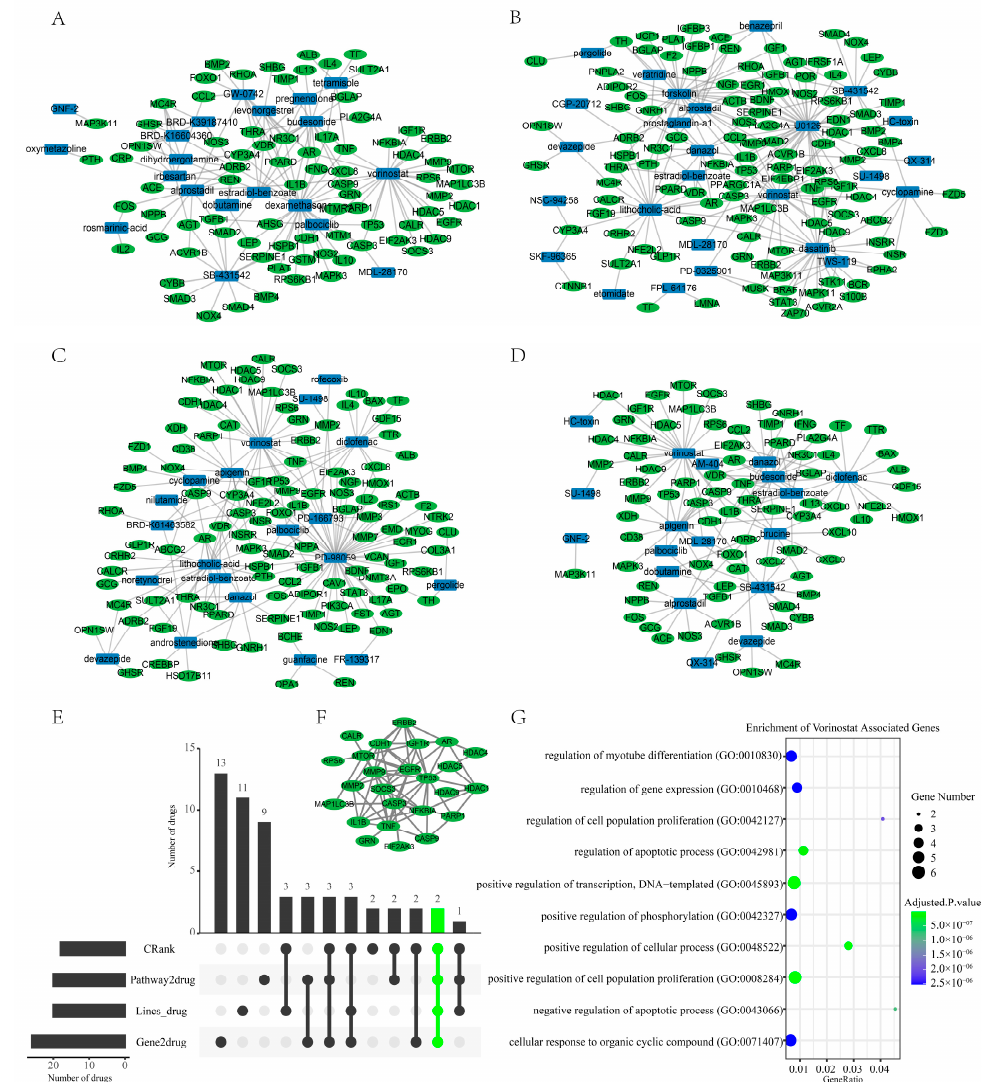
Figure 7. ( A – D ): In the top 50 drugs of the four different approaches, we showed the intersection of each with genes associated with sarcopenia (( A ): Lincs algorithm; ( B ): Gene2drug algorithm; ( C ): Pathway2drug algorithm; ( D ): Crank algorithm). There is no display of drugs that do not interact with sarcopenia-associated genes. ( E ): The UPSet plot shows the intersections of the drugs/small molecules from the four rank lists that have intersected with the sarcopenia-associated genes. ( F ): PPI network of the vorinostat-associated genes. ( G ): Gene Ontology (biological process) enrichment analysis for the 25 genes that are included in the PPI network of vorinostat.